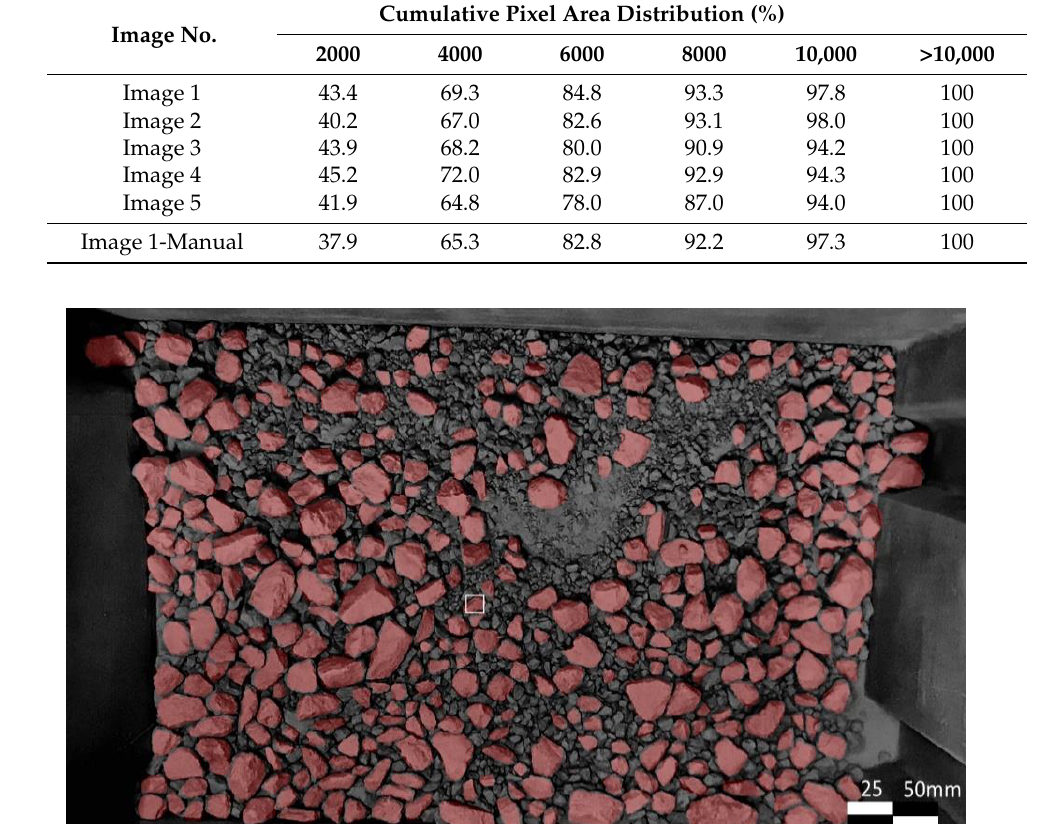
Table 2. The rock pixel cumulative area distribution from images 1 to 5, compared with manual results of image 1. Image No.